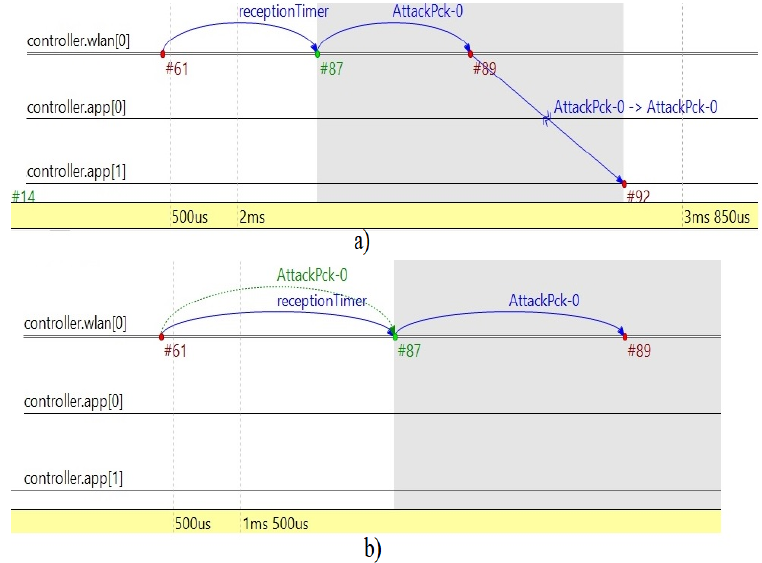
Figure 7. Timeline of simulated transmission of attack packet in wireless (Long Range, LoRa) communication: ( a ) transmitted to the server via gateway application; ( b ) rejected by gateway application with security model.